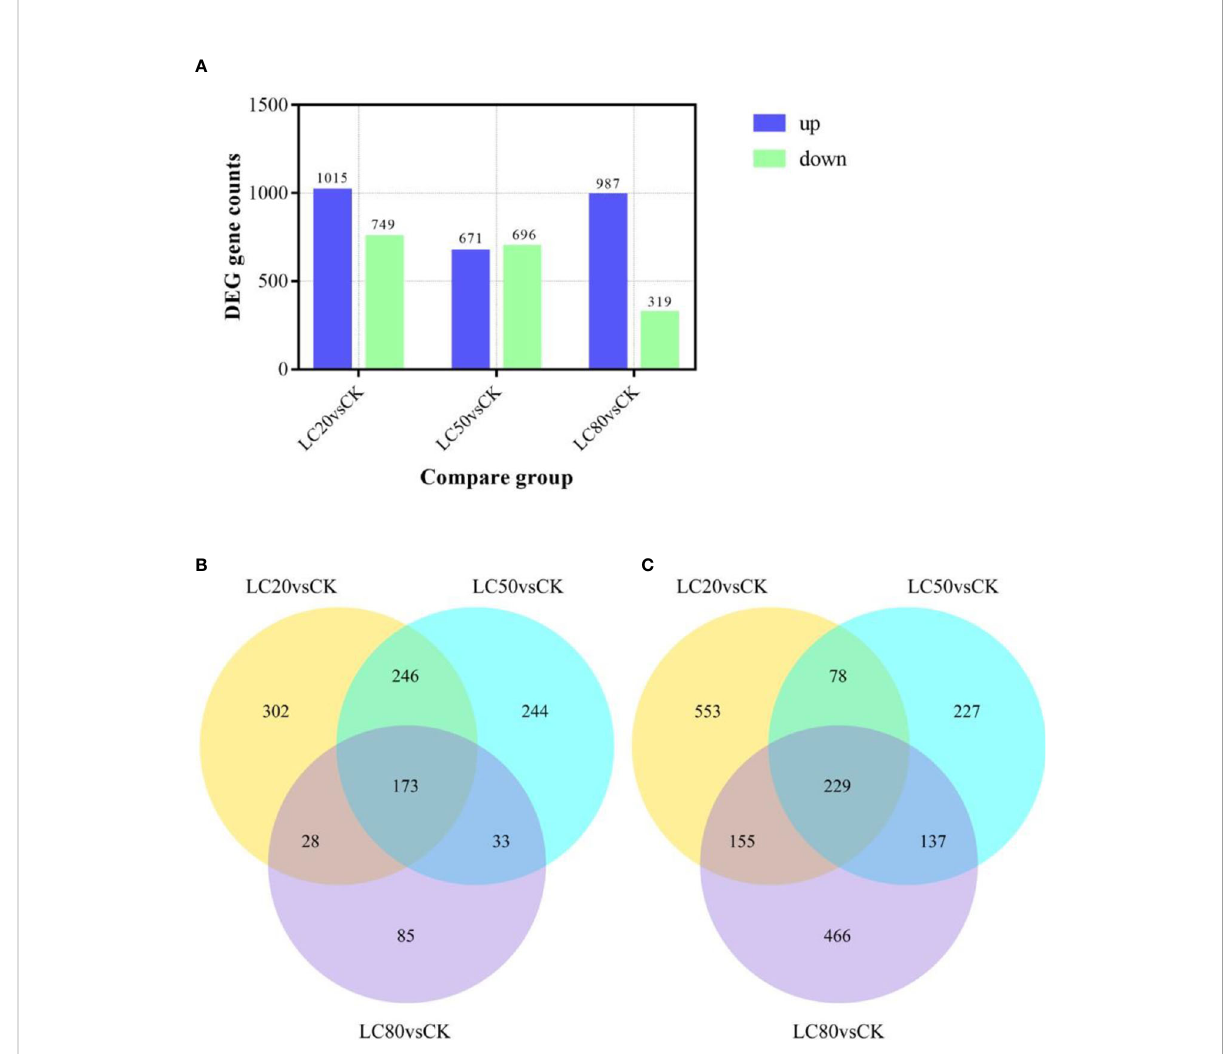
FIGURE 1 The number of DEGs in M. separata larvae treated with different concentrations of CGA. (A) The number of DEGs in different treatment. The number in the column indicates the number of DEGs. (B) The number of DEGs up-regulated by all treatments. (C) The number of DEGs down- regulated by all